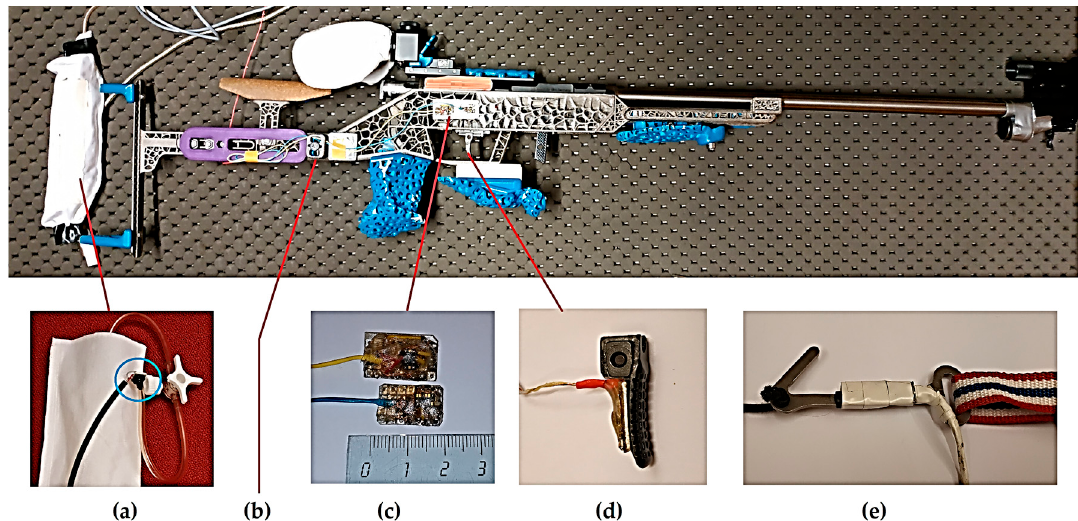
Figure 2. Placement of the sensors: ( a ) pressure sensing airbag; ( b ) signal cable fixation bracket; ( c ) accelerometer and gyroscope boards; ( d ) modified trigger unit; ( e ) load sensitive belt